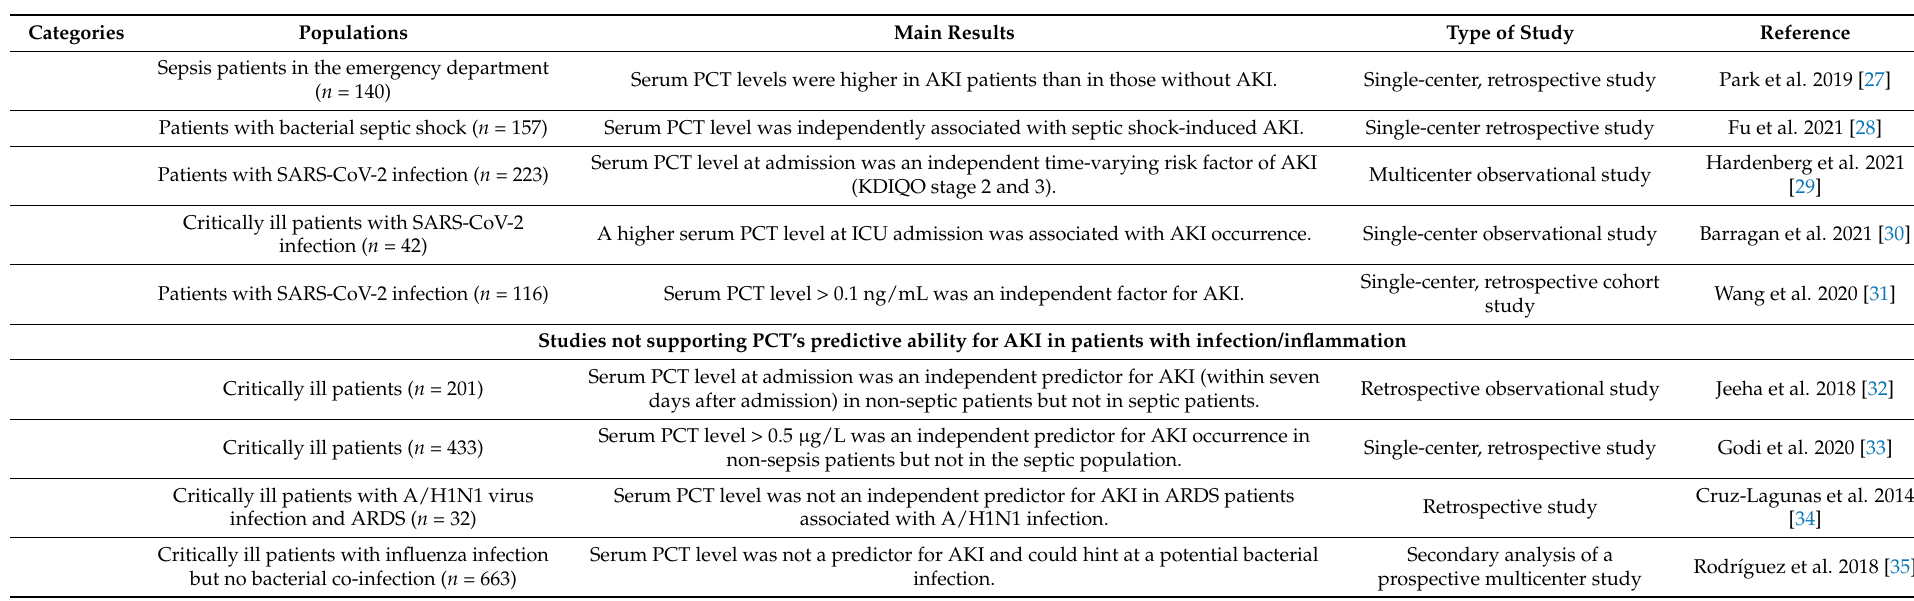
Serum PCT levels were higher in AKI patients than in those without